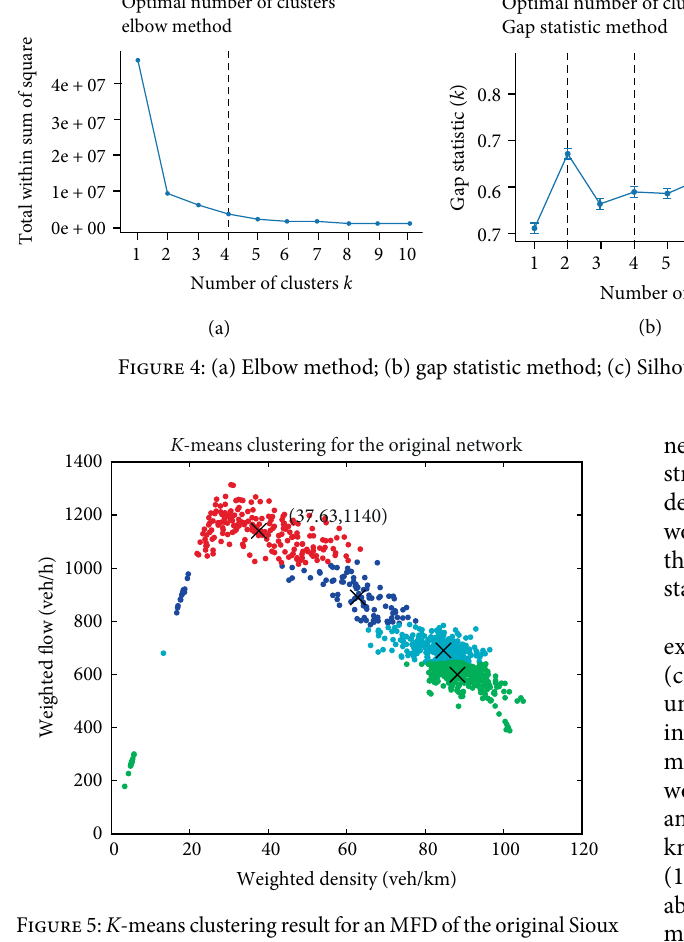
Figure 5: K -means clustering result for an MFD of the original Sioux Falls